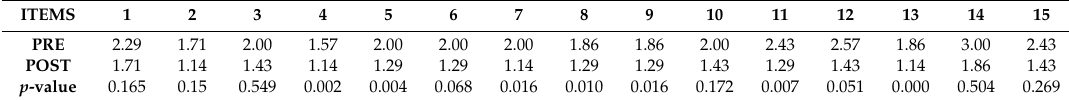
Table 1. DASH score of the mean value of items 1–15.